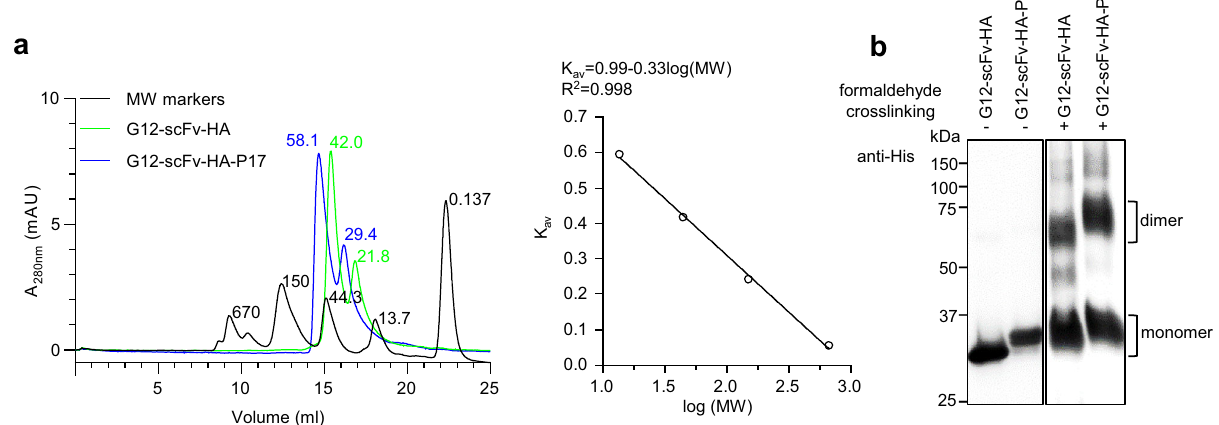
Fig. 10 | P17 tag did not induce oligomerization of G12-scFv. a Size-exclusion chromatography pro fi les of protein markers, G12-scFv-HA, and G12-scFv-HA-P17 proteins. Two hundred μ l protein markers, G12-scFv-HA, and G12-scFv-HA-P17 proteins were loaded onto a Superdex 200 Increase 10/300 column using an ÄKTA puri fi er system. Proteins eluting by PBS at a fl ow rate of 0.5ml/min were monitored by ultraviolet absorbance at 280nm wavelength (A 280nm ). Elution peaks of protein markers (in black), including bovine thyroglobulin, bovine γ - globulin, chicken egg albumin, ribonuclease A, and p-aminobenzoic acid were labeledwith corresponding molecular weights(MWs, 670kDa,150kDa, 44.3kDa, 13.7kDa, and 0.137kDa) in the left panel. Elution peaks of G12-scFv-HA (in green)